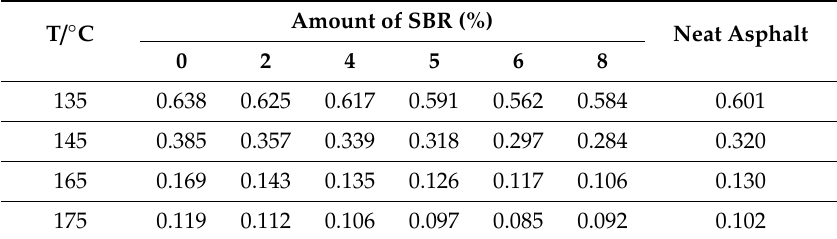
Table 23. Brookfield rotary viscosity of BRA-SBR compound modified asphalt (Pa ·